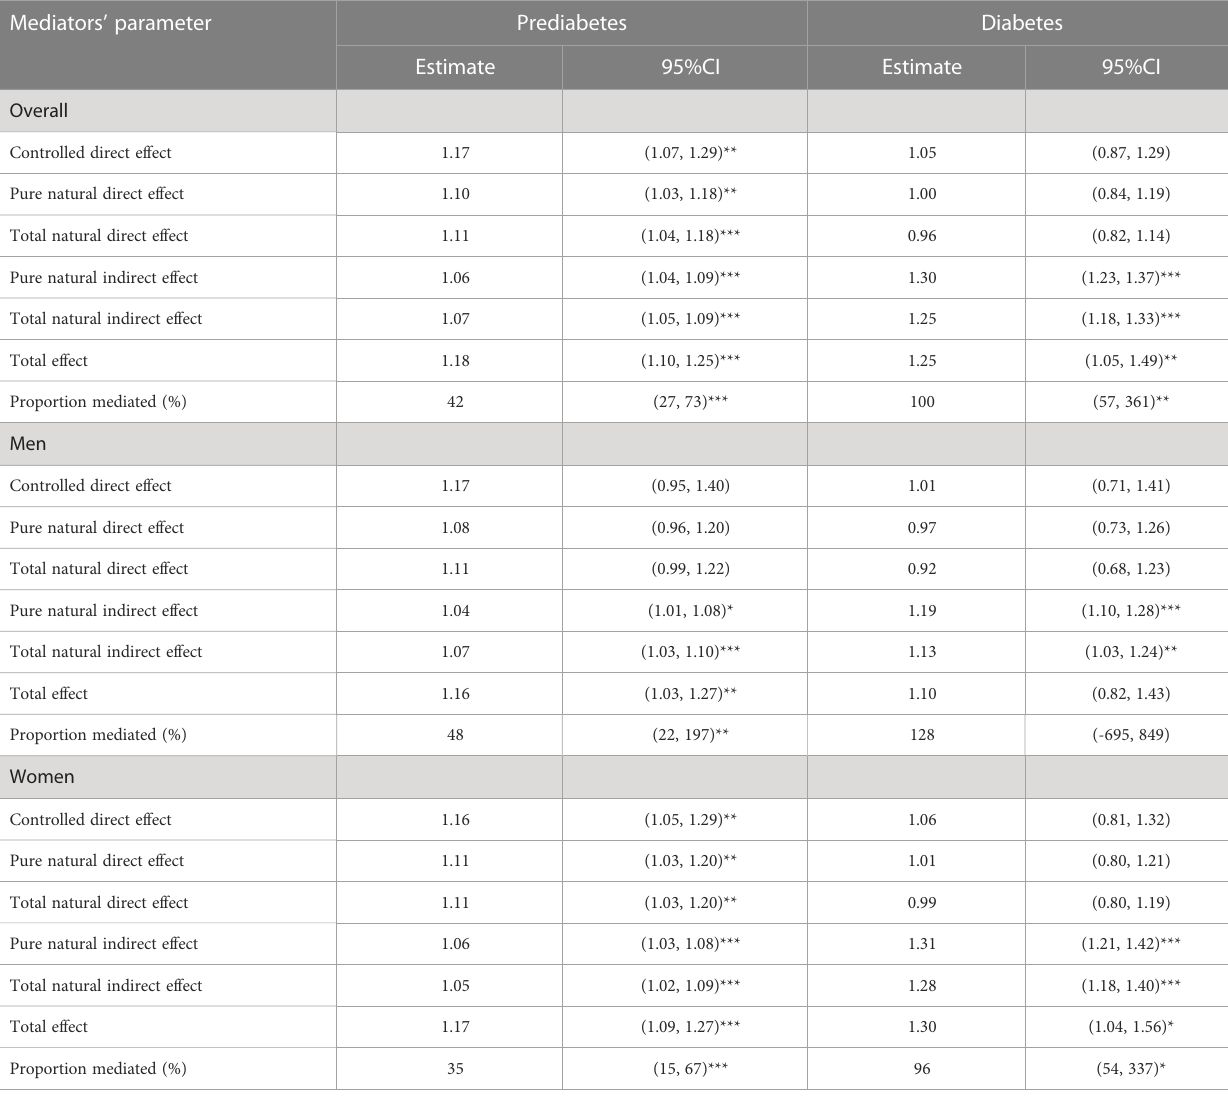
TABLE 3 Prediabetes and diabetes causal risk associated with hyperuricemia based on weighted model jointly mediated by dyslipidemia, body mass index, and fatty